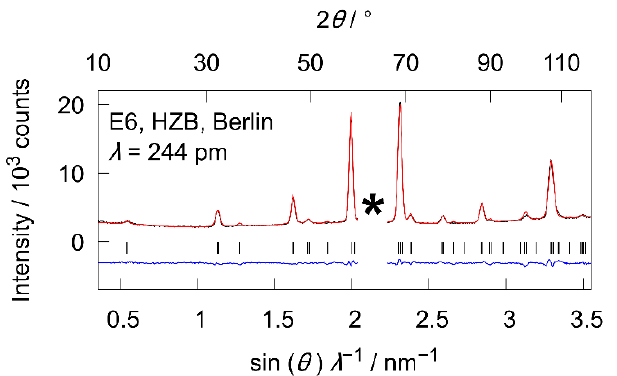
Figure 5. Rietveld refinements of the crystal structure of Ba 2 In 1.8 Cr 0.2 O 5.26(7) at 873(2) K; the excluded region due to contribution of the Nb-heating element of the furnace, is marked with *, R p = 2.56%; R wp = 3.43%; E692936–E692937. The furnace was operated in dynamic vacuum ( p min ≥ 1 × 10 − 3 mbar).